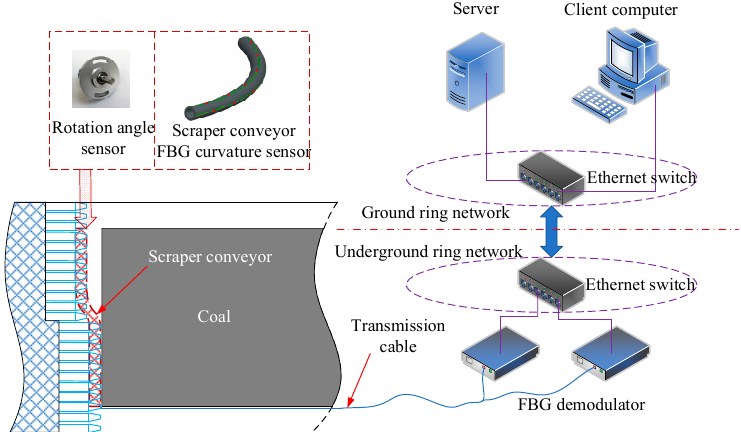
Figure 10. Schematic diagram of high-precision perception of straightness of scraper